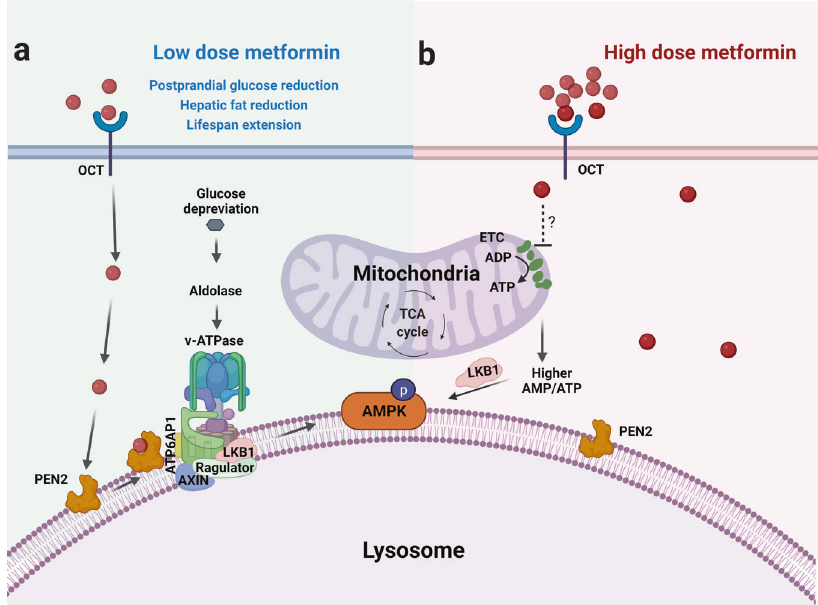
Fig. 1 Schematic illustration of low- and high-dose metformin-induced signalling events leading to AMPK activation. a (green): Low-dose metformin-PEN2 and low-glucose sensor, aldolase signalling intersect at v-ATPase and results in AMPK activation. This is associated with postprandial glucose reduction, hepatic fat reduction, and life span extension. b (red): High-dose metformin activates AMPK signalling independent of the PEN2-ATP6AP1 axis and triggers a spectrum of other pathways. AMP adenosine monophosphate, ATP adenosine triphosphate, AMPK AMP-activated protein kinase, ATP6AP1 accessory factor of v-ATPase, ETC electron transport chain, LKB1 liver kinase B1, OCT organic cation transporters, PEN2 presenilin enhancer 2. The fi gure was created with a paid license on